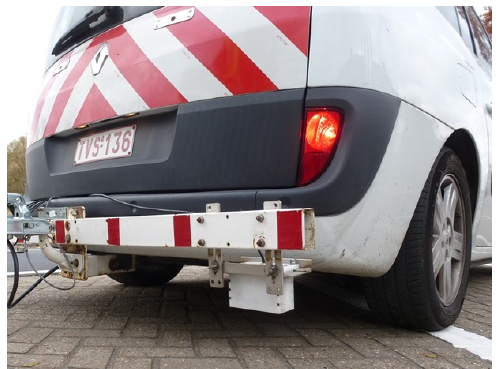
Figure 2. Laser profilometer mounted in the right wheel track.